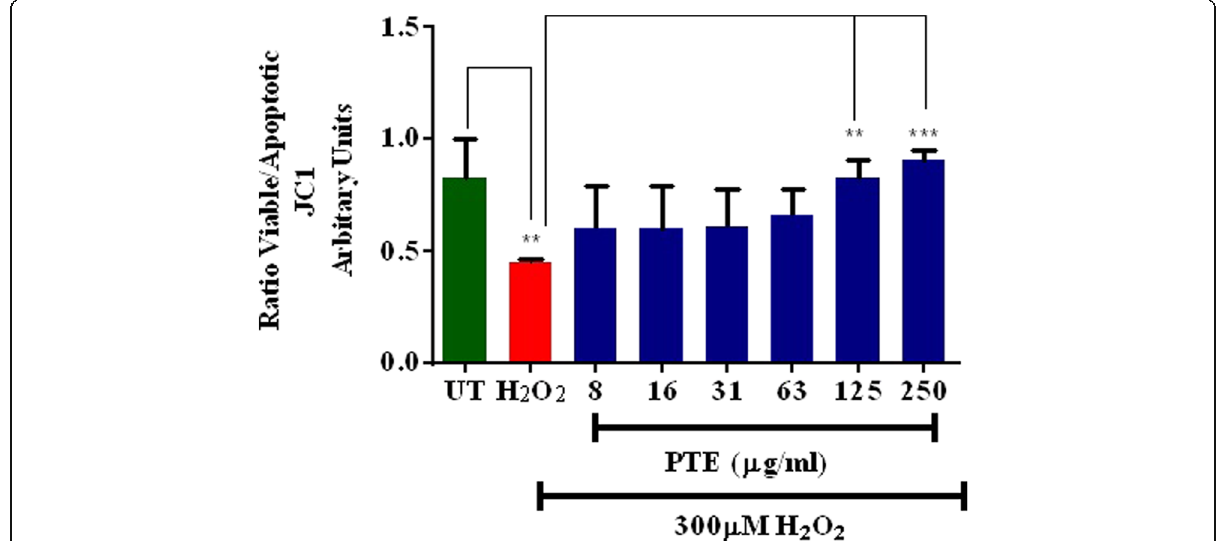
Fig. 6 Effect of PTE pre-treatment (24 h) on H 2 O 2 induced decrease in Mitochondrial Membrane Potential (MMP) in dIMR32 cells. Data reported as Ratio between relative fluorescence unit (RFU) of viable cells / RFU of apoptotic cells. The ratio is an arbitrary unit. The label UT = untreated control cells. The higher ratio shows healthy cells and lower ratio shows apoptotic cells. The data are expressed as mean ± SEM, n = 3. Statistical significance was analyzed with one-way ANOVA followed by a Dunnett ’ s multiple comparison post-hoc test. Differences with p value less than 0.05 and less than 0.001 were considered statistically significant. ** p < 0.05 and *** p < 0.001 compared with H 2 O 2 treated cells